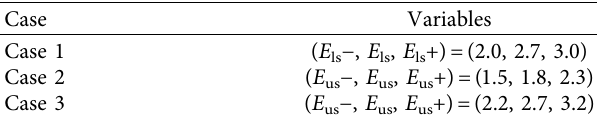
Figure 12: Contour plot of R a ui with various ε ls and ε us (Case 3). Table 3: Variables for